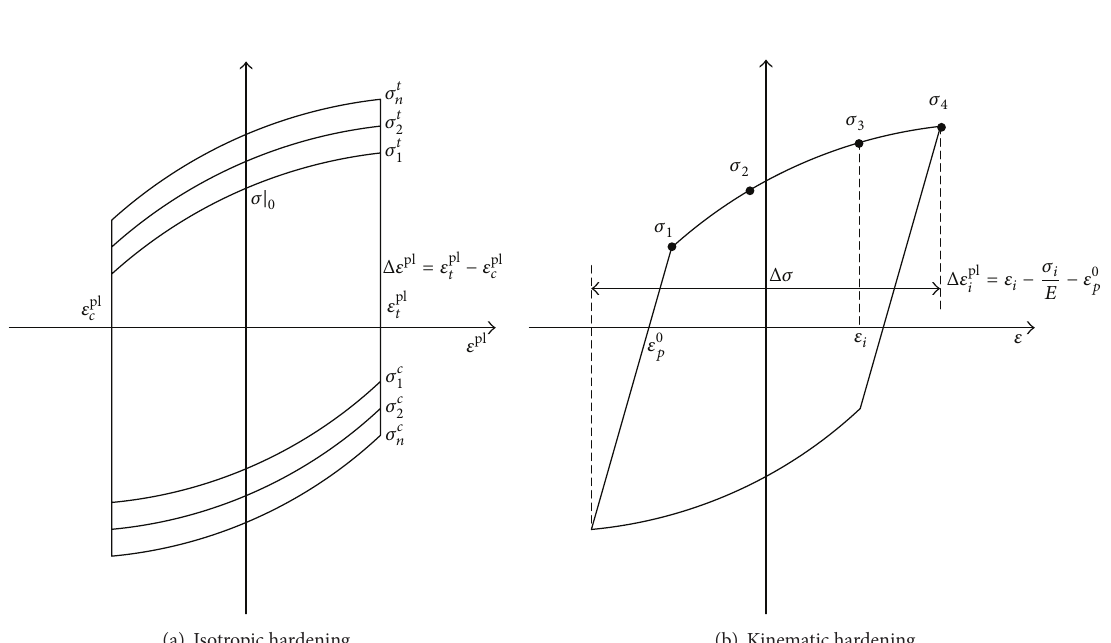
Figure 10: Microfailure modes of fracture surface.